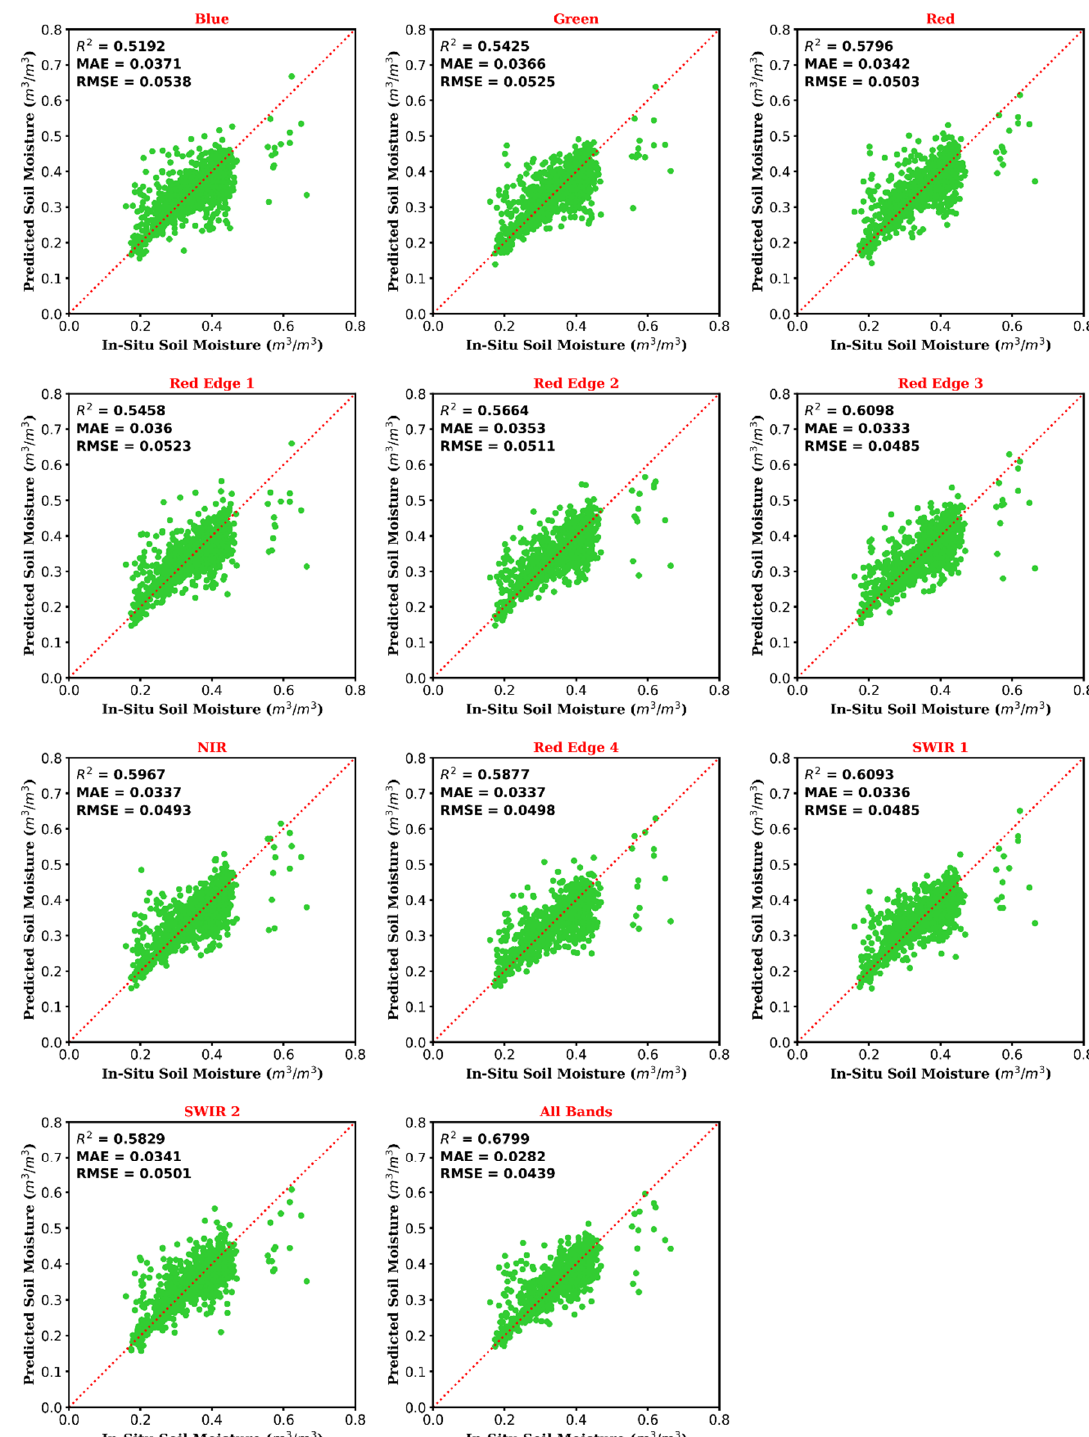
Figure 3. Results of using Sentinel-2 bands as input data to the CNN architecture (3).